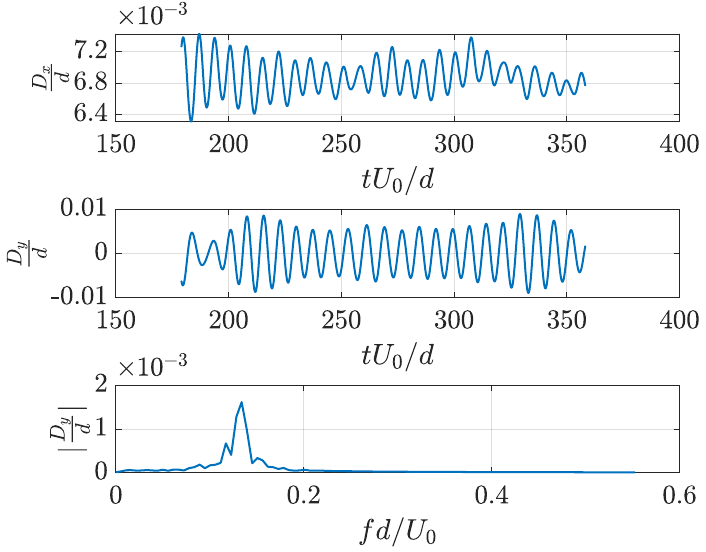
Figure 9. Time record of the displacement of the edge of the cylinder: displacement in the direction of motion ( top panel); displacement in the transversal direction ( middle panel); spectrum of the transverse displacement ( bottom panel); time record in the time interval 180–360 tU 0 / d